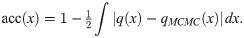
Box plots of the accuracy measurements for the model parameters associated with the Laplace (L-dark boxes) and Tangent (T-light boxes) based method for number of sites n = 50, 100 and number of visits to each site K = 2, 5.The detection and occupancy probabilities are approximately 0:5. The accuracy of the VB approximations is measured by calculating acc(x)=1−12∫|q(x)−qMCMC(x)|dx. The measure lies between 0 and 1 with a value of 1 indicating a perfect approximation and a value close to 0 indicating a poor approximation by the variational distribution to the true posterior distribution.